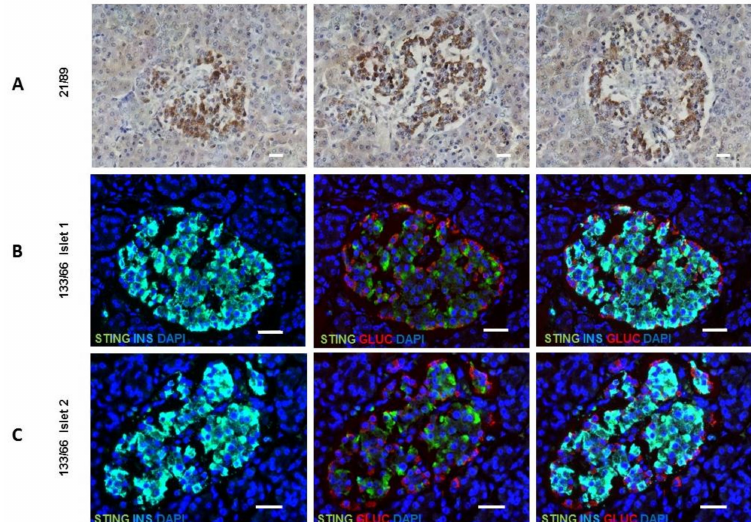
Figure 6. STING expression is present in the islets of human individuals in both early and late life. ( A ) Immunohistochemical localization of STING in 3 different islets from an individual (sample number 21/89) aged 4 years using DAB chromogen. ( B , C ) Images demonstrating that STING is localized to the β -cell. Immunostaining for STING (green) and insulin (light blue; left panel), STING (green) and glucagon (red; middle panel) or STING (green) glucagon (red) and insulin (light blue; right panel) is shown in two representative islets from an older individual (sample number 133/66) aged 80 years. Scale bars represent 30 µ